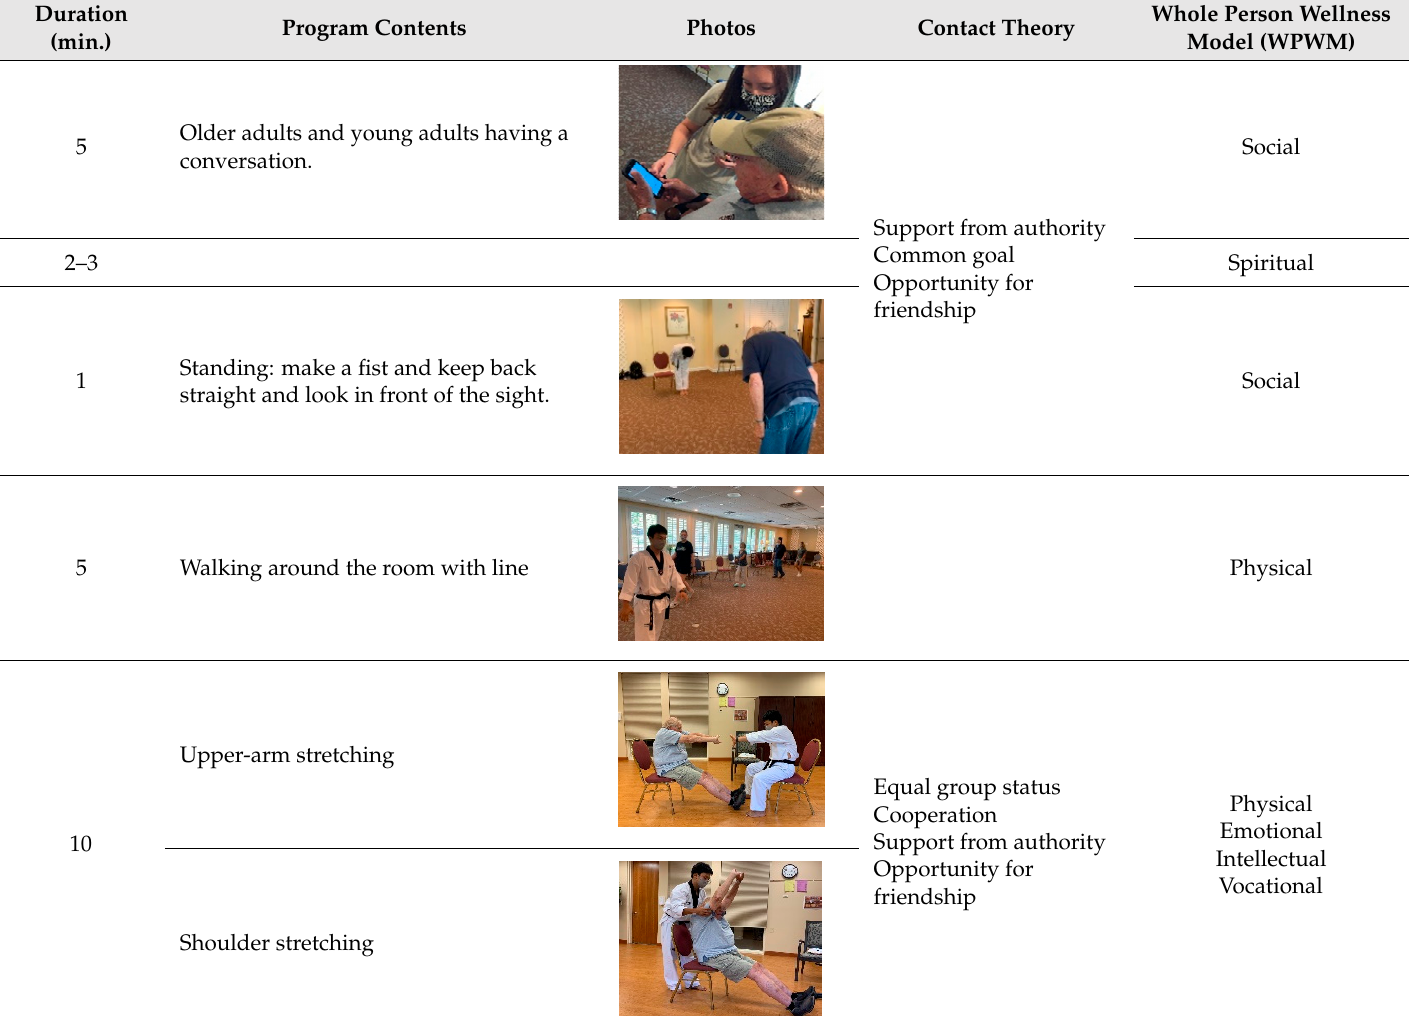
Table 2. Development of Intergenerational Taekwondo Program.